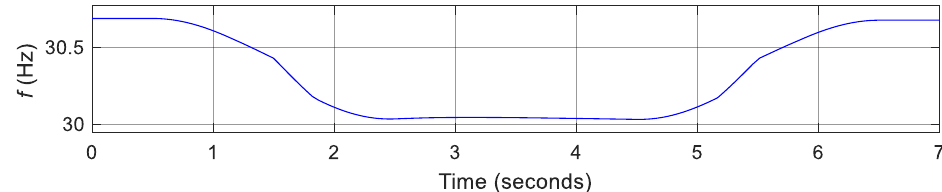
Figure 19. Flight control simulations for transition flight control of linear FWMAV model.